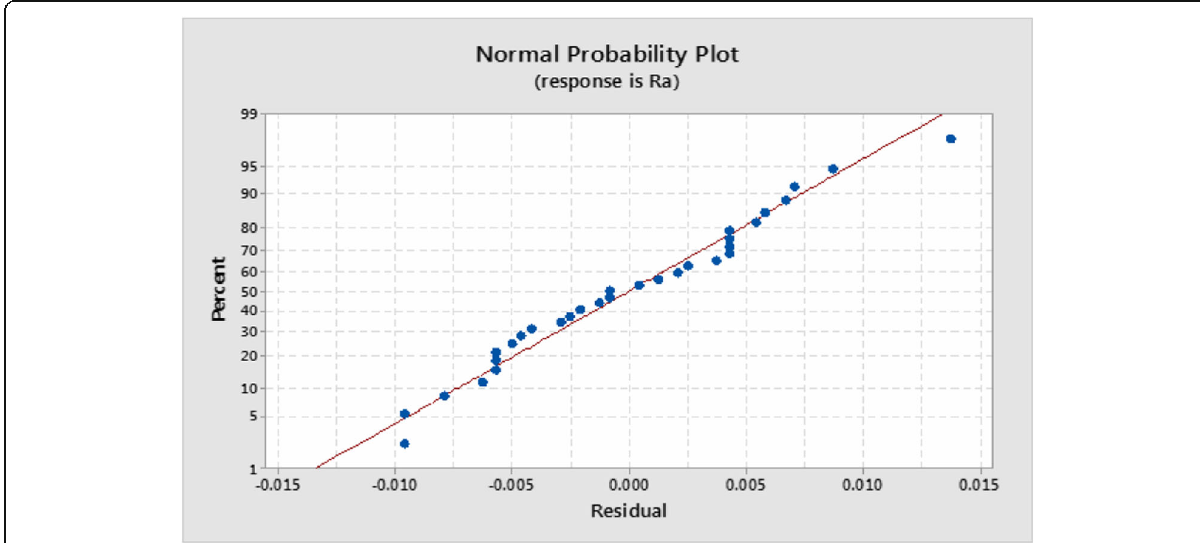
Fig. 2 Normal probability plot of residuals for R a